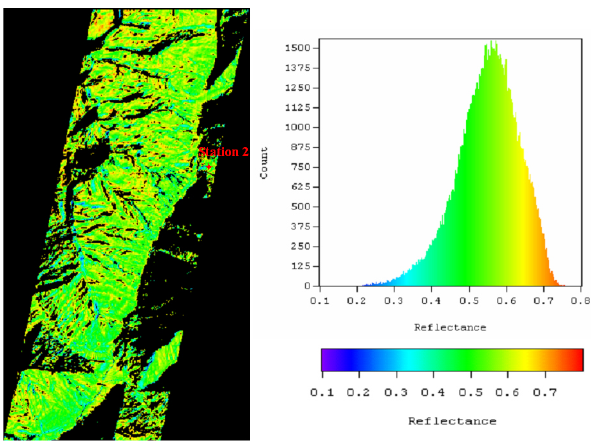
Fig. 10. The spatial distribution of reflectance at 1240nm and its histogram measured by Hyperion data over a part of middle Hi- malaya.